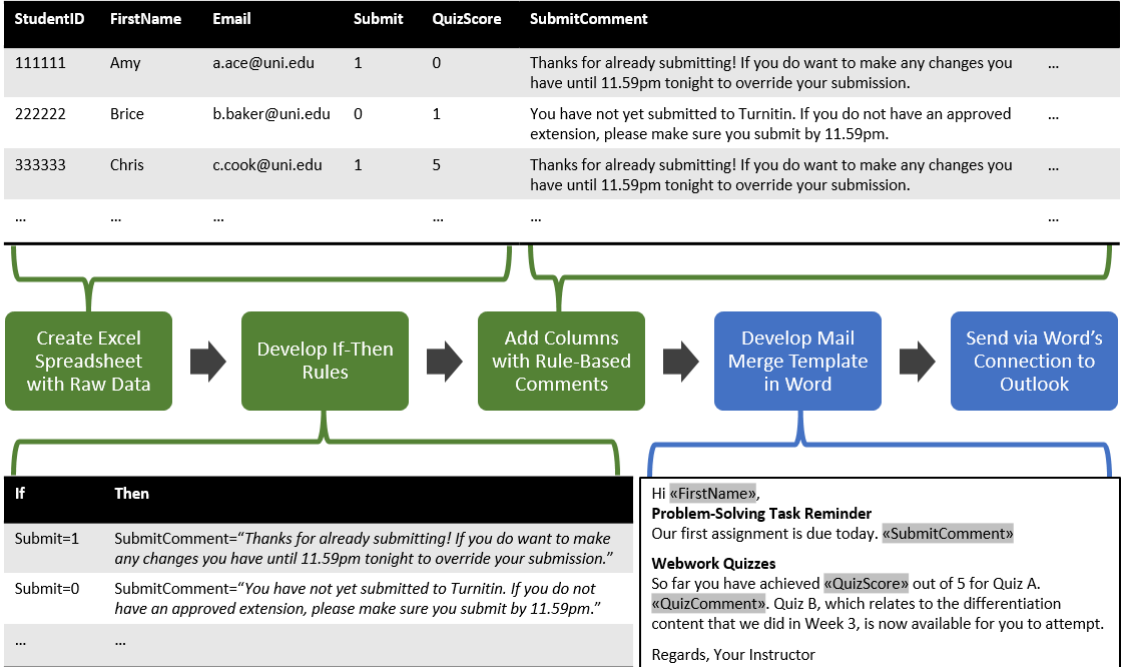
Process for Generating Personalised